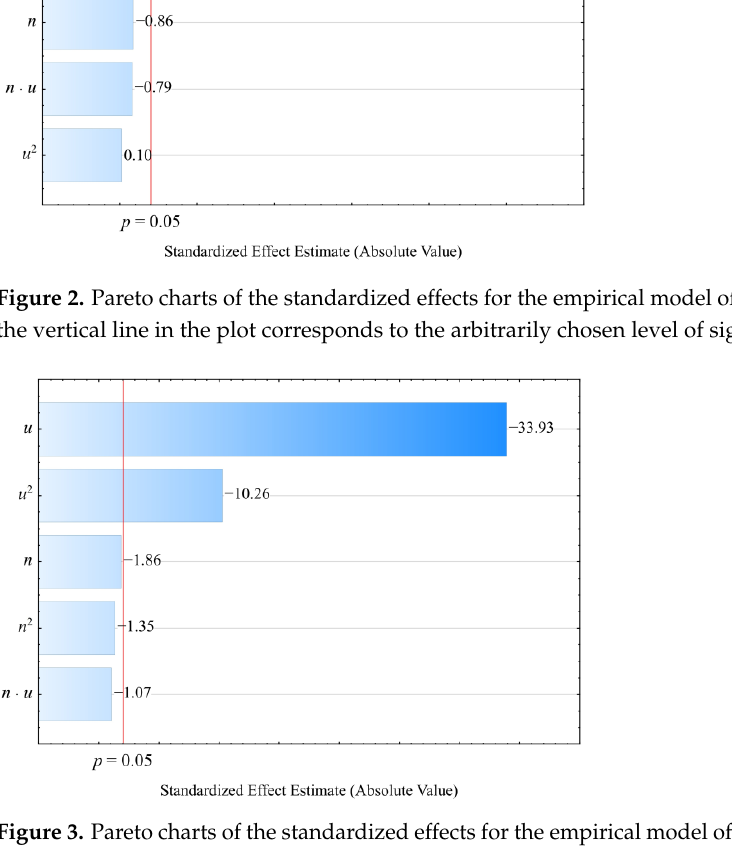
Figure 4. Response surface graph for the longitudinal shrinkage S L versus wheat bran content u and screw speed n. Figure 5. Response surface graph for the transverse shrinkage S T versus wheat bran content u and screw speed n.